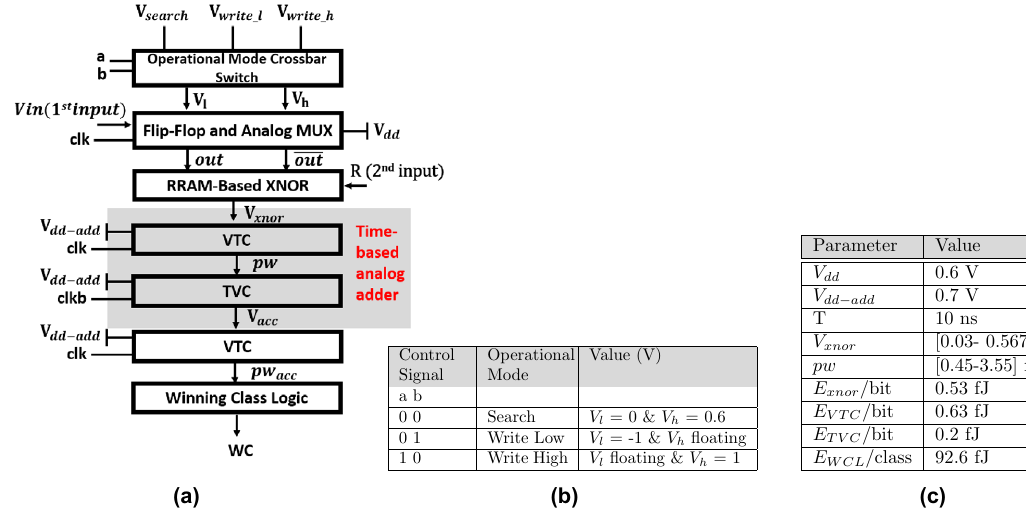
Figure 2. ( a ) Proposed time-domain RRAM-CAM Hamming distance and winning class data-flow block. ( b ) Proposed Design Operational Modes and Control Signals. ( c ) Proposed Architecture Design Parameters and Energy